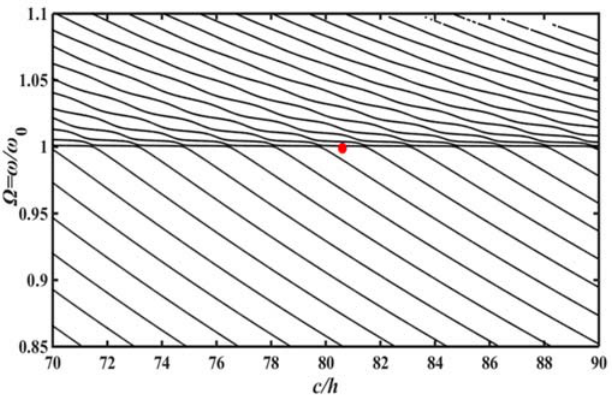
Figure 3. The YCOB crystal plate’s frequency spectra curves under LFE.